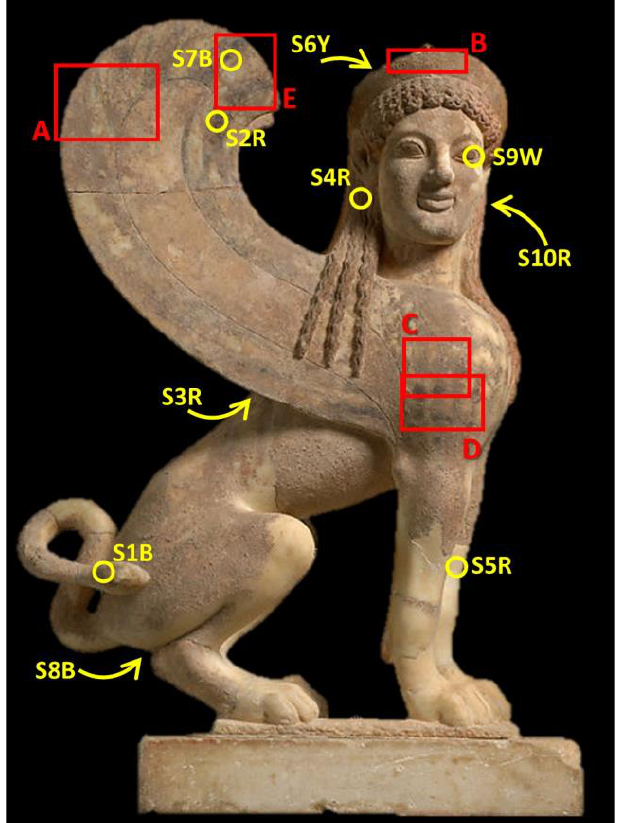
Figure 4. Locations of XRF maps and micro-samples. The arrows indicate sampling locations that are not visible in this frontal image.